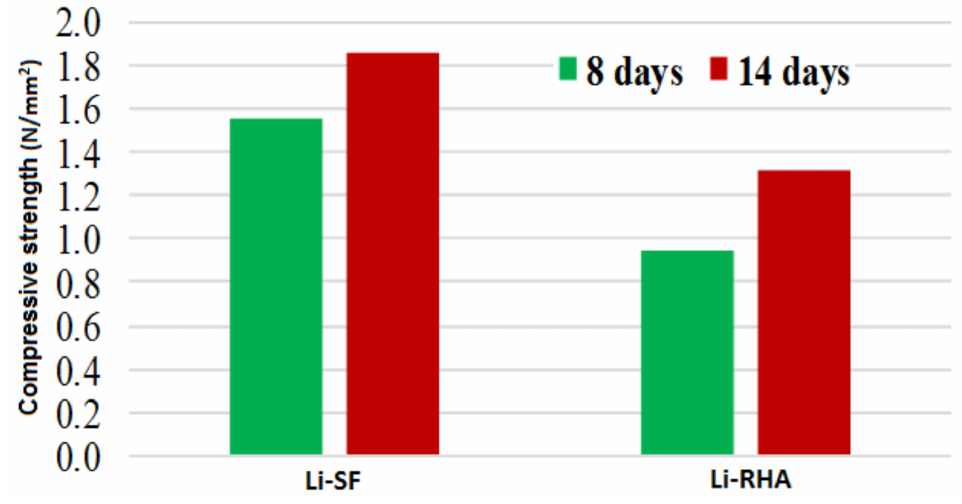
Figure 5. Lime reactivity